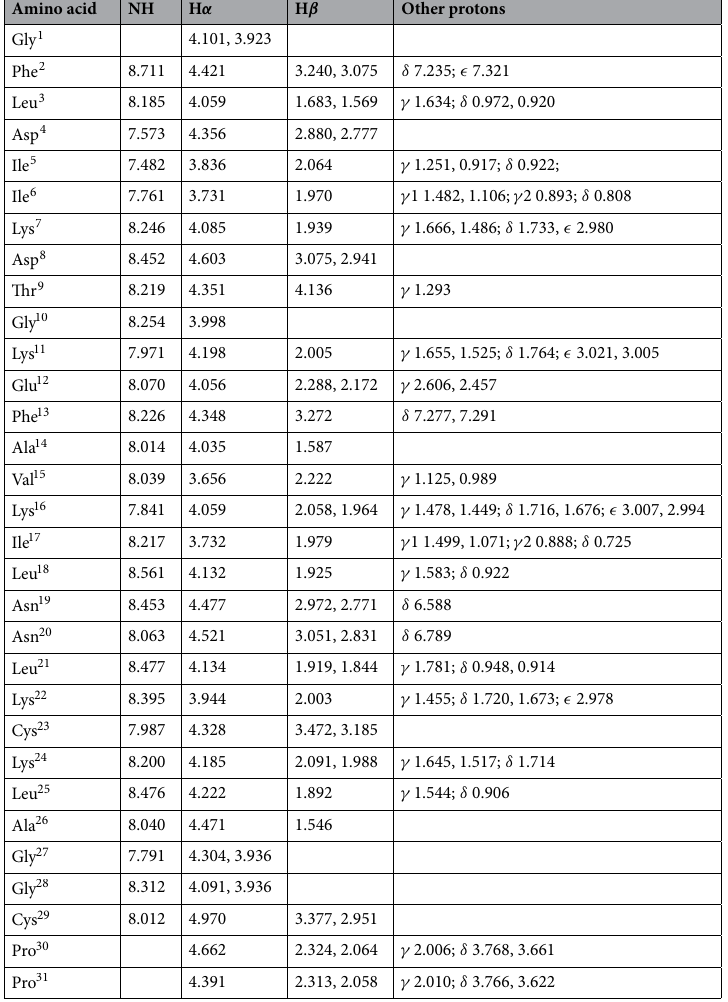
1 Table 1. H chemical shifts (ppm) identified for every residue of palustrin-Ca in 50% TFE- d 3 /H 2